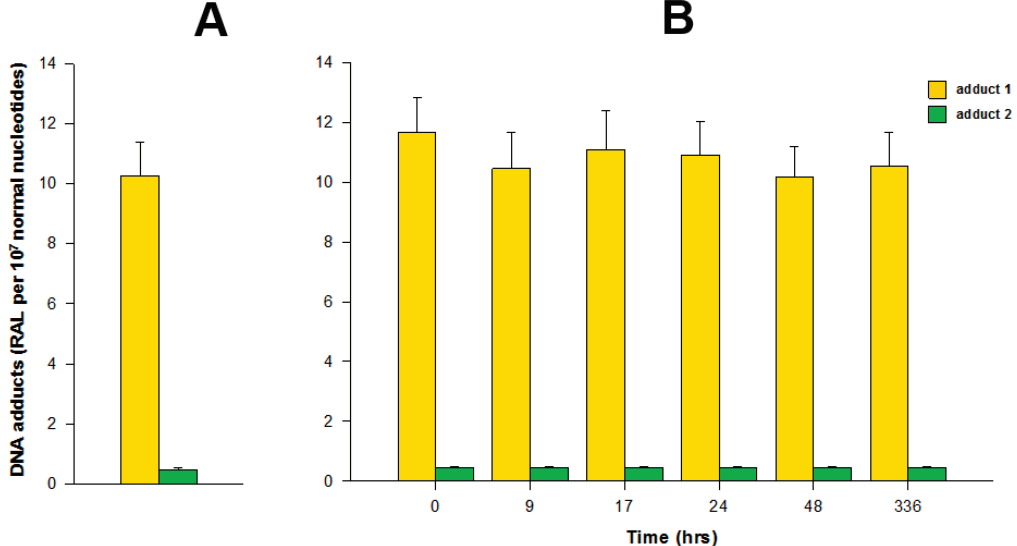
Figure 3. Ellipticine release from ellipticine-micelles and its transfer into rat liver microsomes. Efficiencies of transfer was measured by formation of ellipticine-derived DNA adducts (adducts 1 and 2 generated by 13-hydroxyellipticine and 12-hydroxyellipticine, respectively, see Figure 1) formed from the released ellipticine activated by rat liver microsomes. Formation of ellipticine-derived DNA adducts by free ellipticine ( A ) and released ellipticine ( B ) activated with rat liver microsomes were determined by the 32 P-postlabeling method. Data shown are means ± S.D. from three parallel experiments. RAL, relative adduct